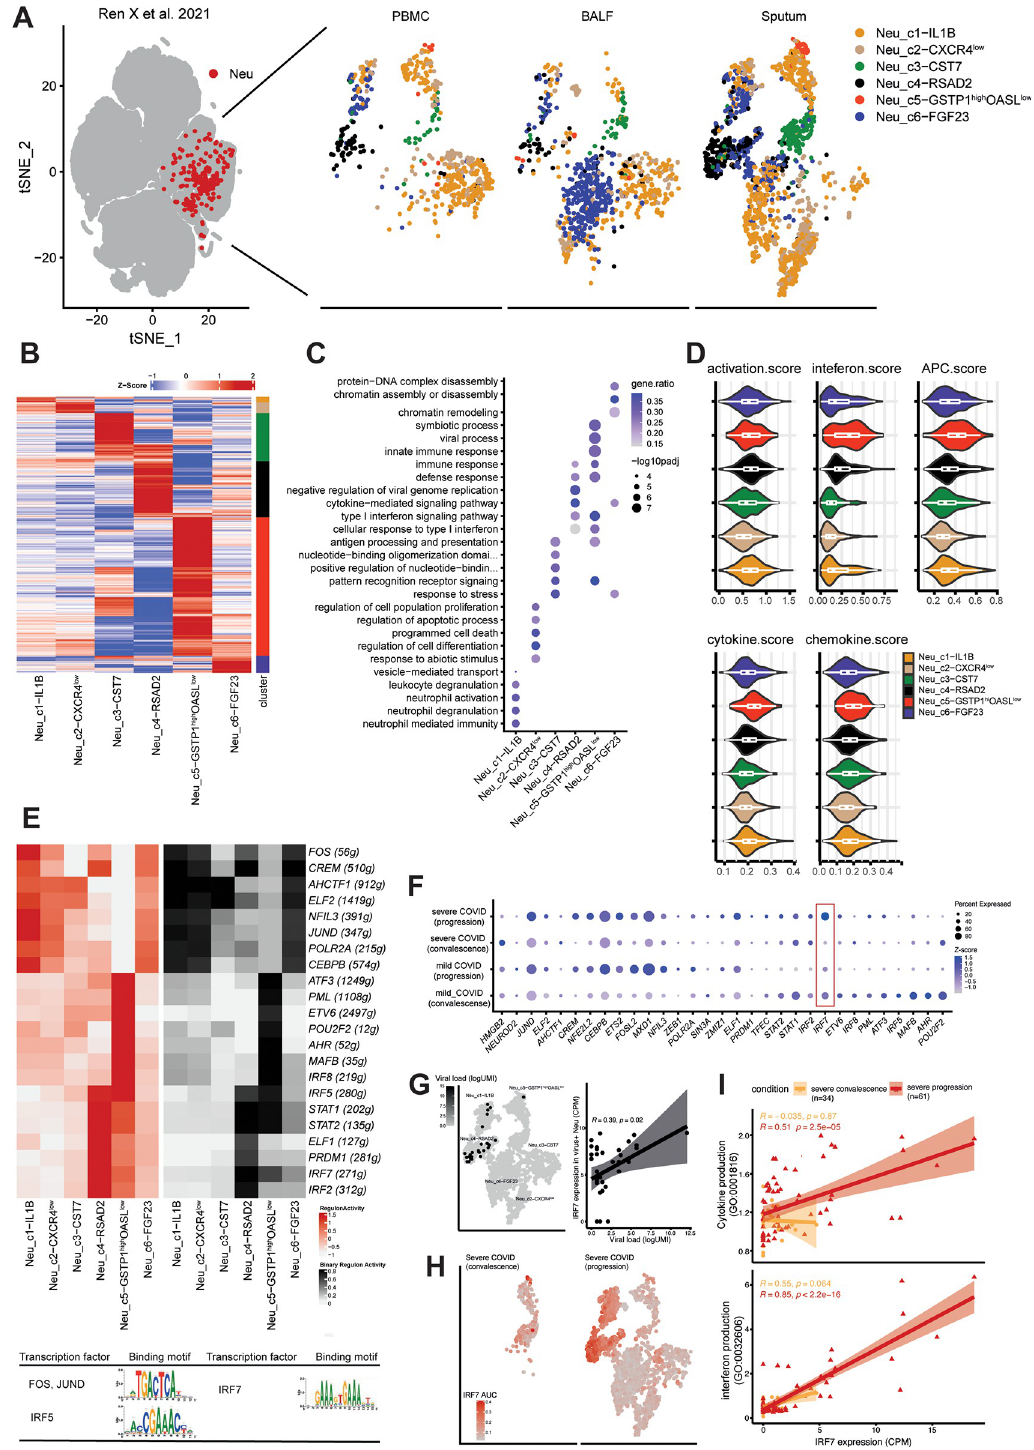
Fig 4. Neutrophil transcriptional regulatory networks in COVID19 infection. (A) The t-SNE presentation showing major neutrophil subpopulations from the peripheral blood, bronchoalveolar lavage fluid, and sputum from COVID19 patients. (B) Hierarchical clustering of differentially expressed genes (DEGs) (padj < 0.01, |log2FC| > 1), based on Manhattan distances using the Ward method. Data are presented as heatmap normalised to the minimum and maximum of each row. (C) The gene ontology analysis of DEGs by each neutrophil subpopulation indicated in (B). (D) the average expression levels of genes